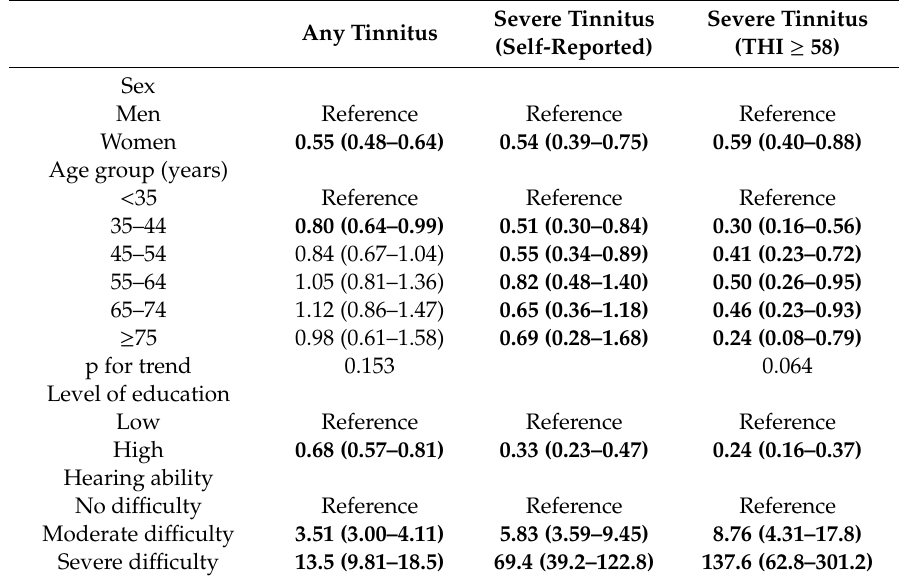
Table 2. Odds ratios (OR) a for any tinnitus, severe tinnitus (THI ≥ 58), and self-reported severe tinnitus, and corresponding 95% confidence intervals (CI), according to sex, age, level of education, and hearing ability. Sweden, 2016–2018.